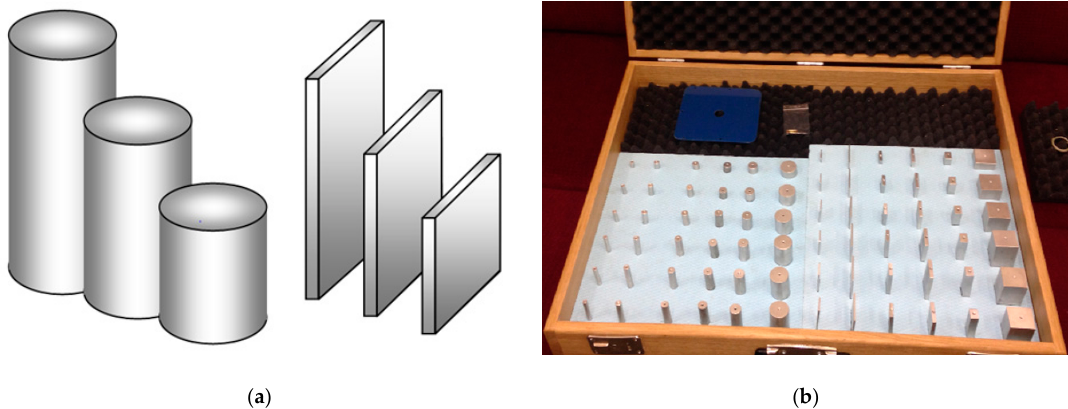
Figure 1. Measured antennas: ( a ) Illustration of cylindrical and flat antennas; ( b ) A dozen models produced of sets of antennas.